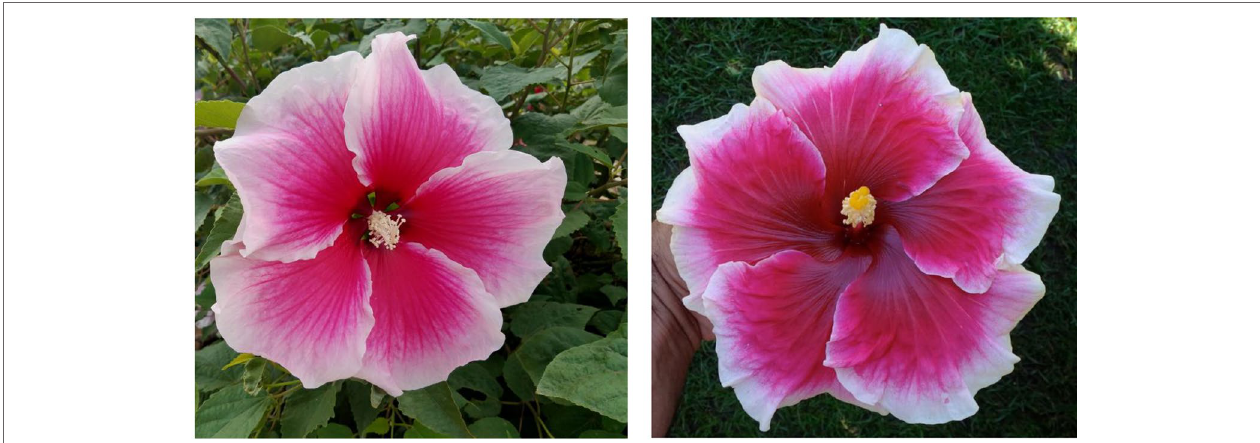
FIGURe 1 | Flower color and shape of H. x moscheutos hybrid “TAMUS-5036” (left) and H. rosa-sinensis “Cindy’s Heart” (right). Photo credits: Dariusz P. Malinowski (“TAMUS-5036”) and Darren Eminian (“Cindy’s Heart”), Colorlicious Landscaping. Used with permission.